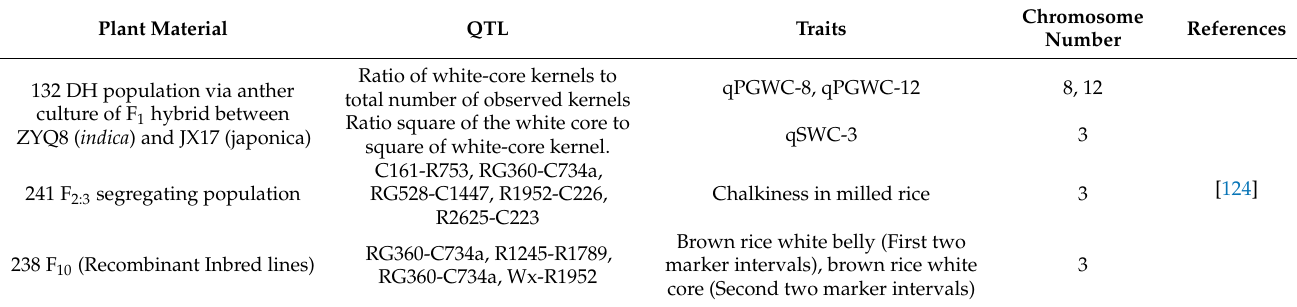
Table 6. Quantitative traits loci for chalkiness in rice